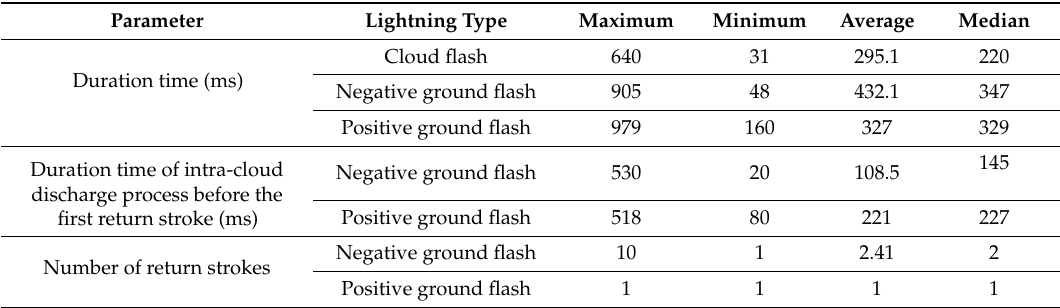
Table 1. Statistics of parameters related to different flash types (Unit: milliseconds,